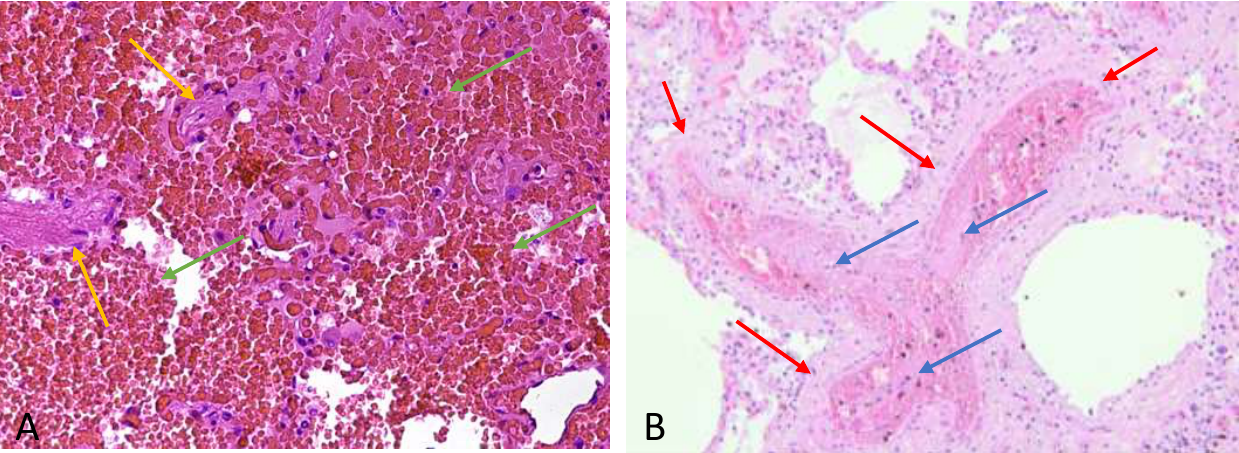
B A Figure 2. ( A ) Extensive intra-alveolar hemorrhage, the alveolar spaces (alveolar septum yellow arrow) are filled by erythrocyte (green arrow) without fibrin and granulocytes (H&E 200 X) ( B ) Microvascular thrombi (H&E 100 X) in the arteriolar lumen (arteriole wall red arrow) there is microembolism consisting of fibrinous meshes that retain leukocytes and platelets (blue arrow).